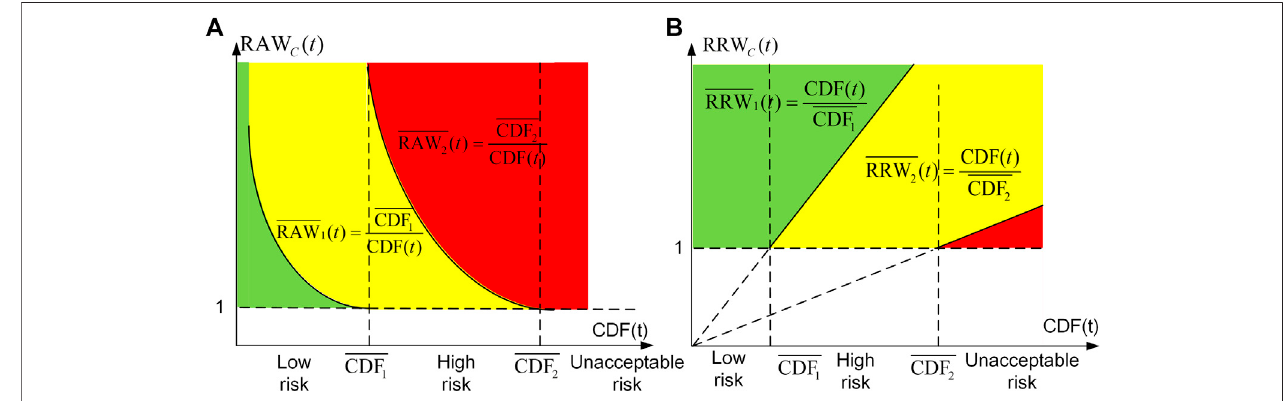
FIGURE 7 | Time-dependent criteria of SSC importance. (A) RAW. (B) RRW